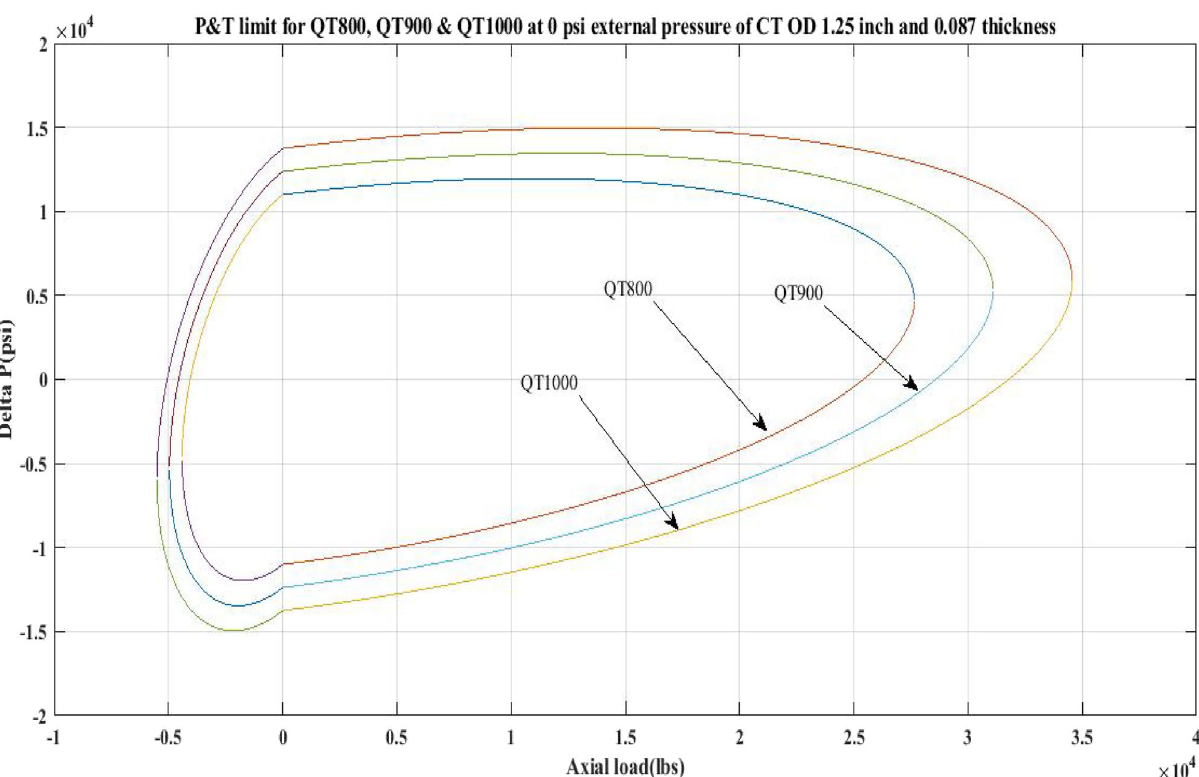
Figure 1. Limit curves for QT 800, QT900 and QT 1000 at zero P o for the CT with 1.25 inch OD and 0.087 inch